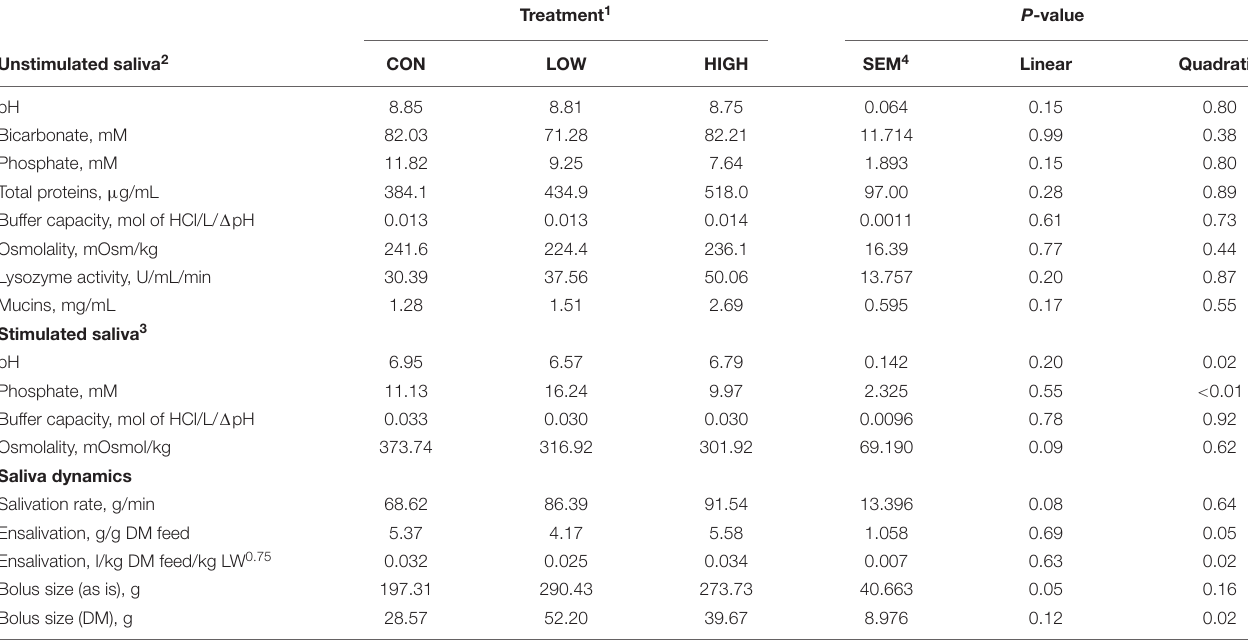
TABLE 7 | Effect of supplementation with mint oil on salivary physico-chemical properties, salivation, and feed bolus dynamics of non-lactating Holstein dairy